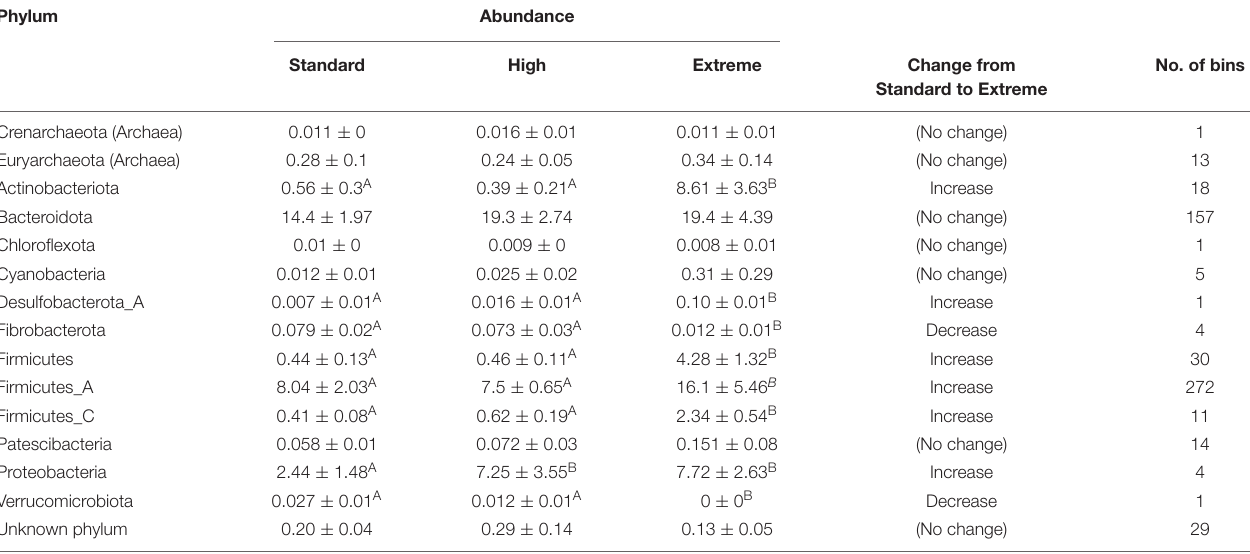
TABLE 3 | The abundance change summaries of the 561 assembled genomes by the phylum of the individual bins (a bin indicates a full or partially assembled genome in the rumen microbiome; only the DNA, which could be assembled into bins with completeness of at least 10%, is included).